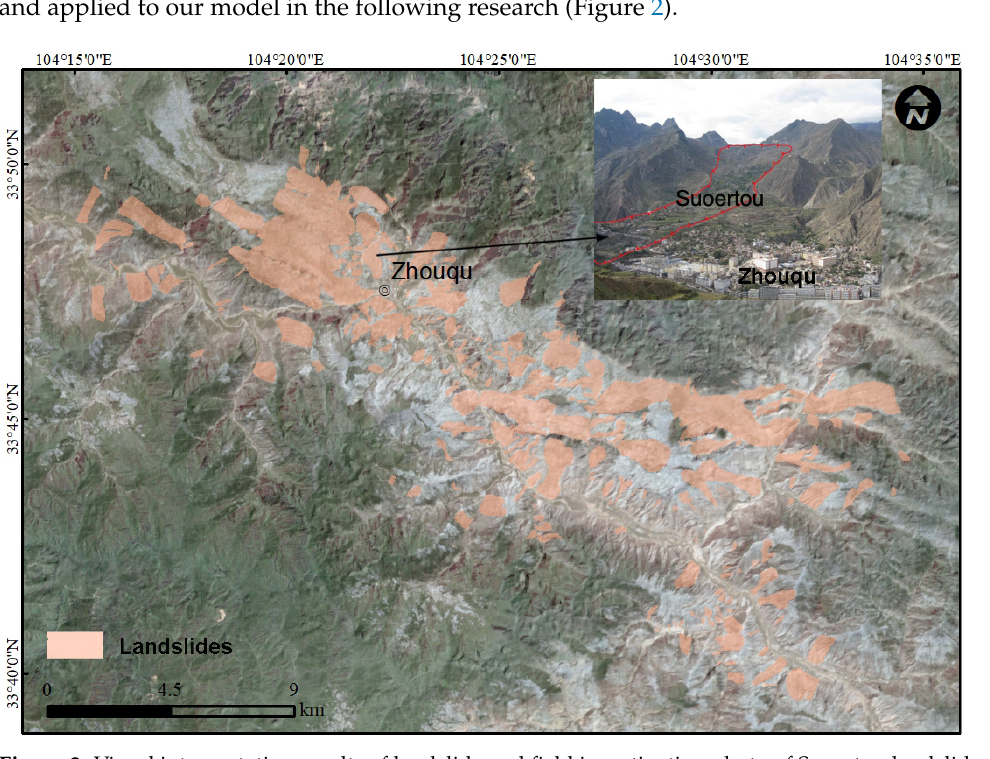
Figure 2. Visual interpretation results of landslide and field investigation photo of Suoertou landslide in the study